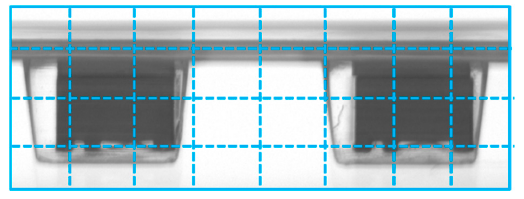
Figure 11. Example of CLAHE Grid.